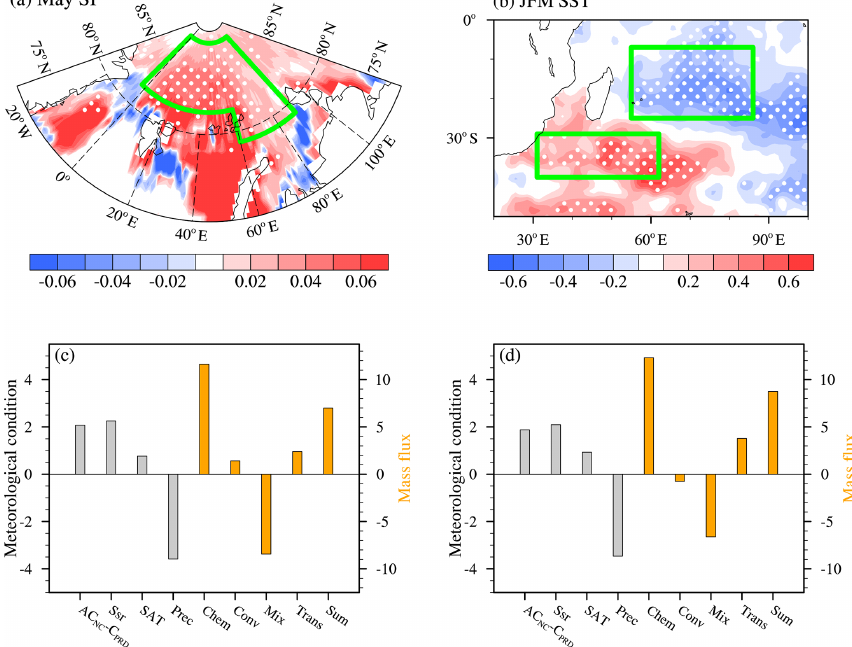
Figure 4. Composites of (a) May SI concentration and (b) JFM SST associated with the DP-O 3 (DP-O 3 P minus DP-O 3 N) from 1980 to 2019. The green boxes in (a) and (b) indicate where the SI FJL and SIOD indices are calculated, respectively. The white dots indicate that the composites were above the 90% confidence level. Composite summer meteorological conditions, circulations, and mass fluxes of O 3 associated with (c) SI FJL (positive SI FJL years minus negative SI FJL years) and (d) SIOD (positive SIOD years minus negative SIOD years) from 1980 to 2019. The bottom axis gives the names of the meteorological conditions and chemical and physical processes: the differences between AC NC and C PRD (unit: 10gpm), surface incoming shortwave flux (Ssr, unit: Wm − 2 ), surface air temperature (SAT, unit: K), precipitation (Prec, unit: mm), chemical reaction (Chem, unit: td − 1 ), convection (Conv, unit: td − 1 ), PBL mixing (Mix, unit: td − 1 ), transport (Trans, unit: td − 1 ), and their sum (Sum, unit: td − 1